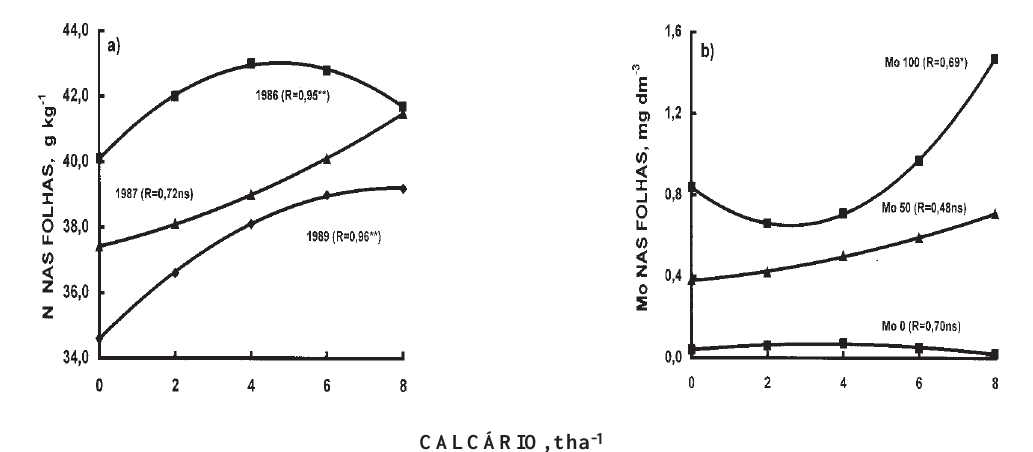
aplicação de Mo pouco alterou as concentrações de outros nutrientes, além do N e do próprio Mo. Alguns efeitos, apesar de serem significativos pela análise de variância conjunta, foram pouco